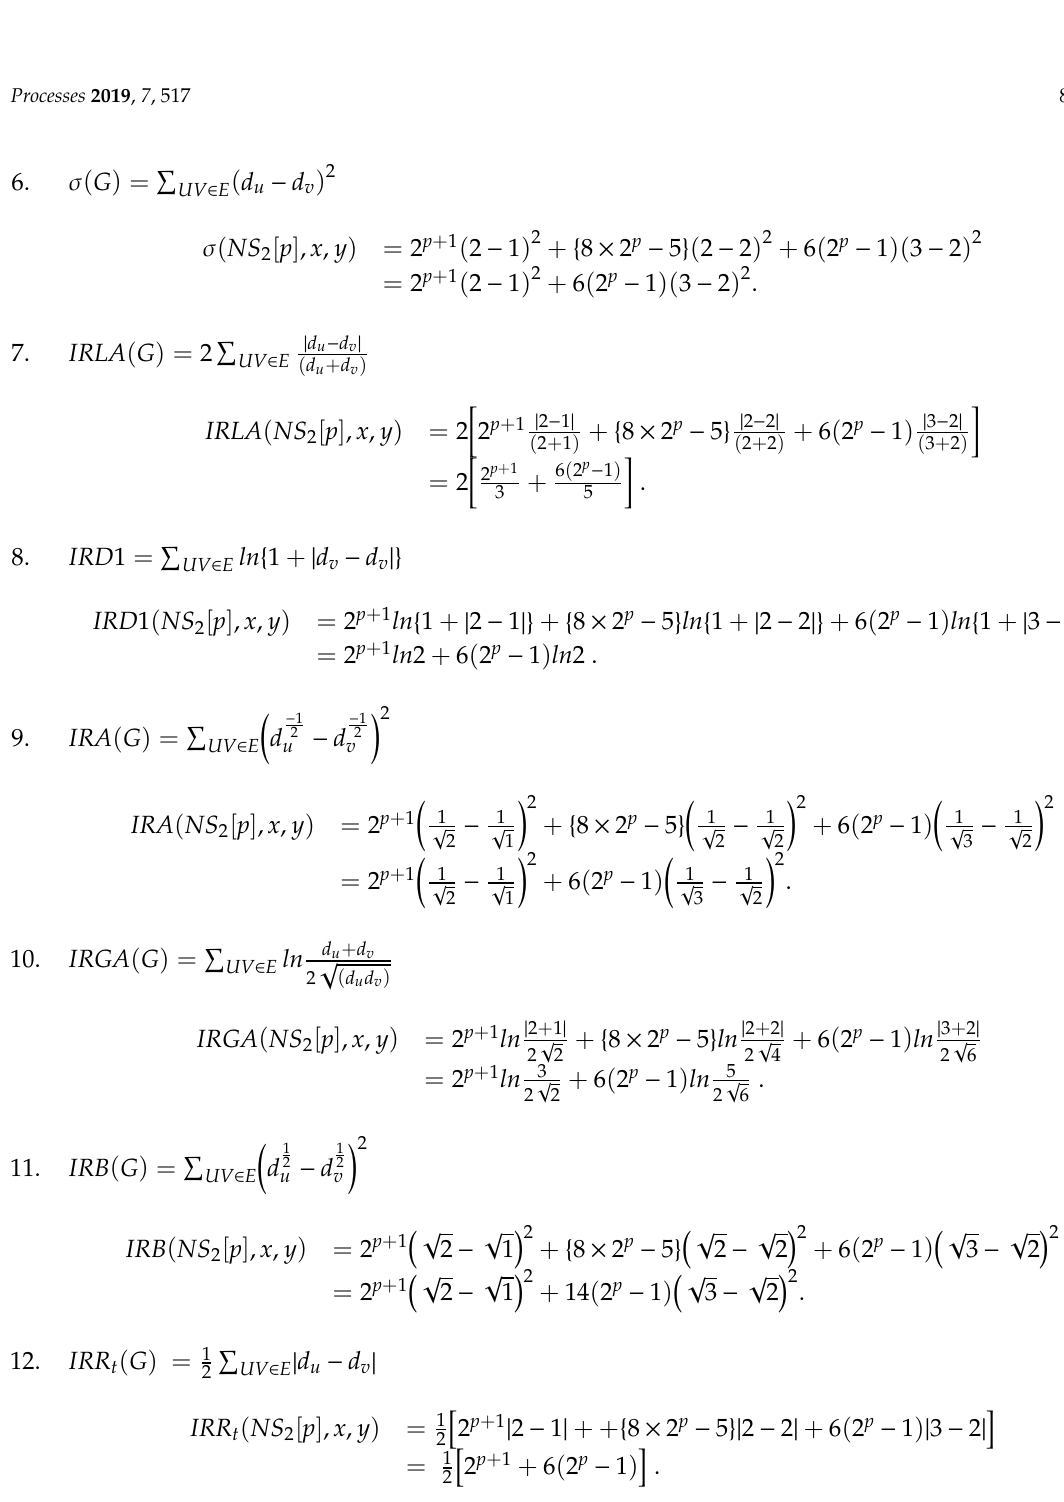
Table 4 represents some calculated values of irregularity indices of NS 2 [ p ] for some test values of p